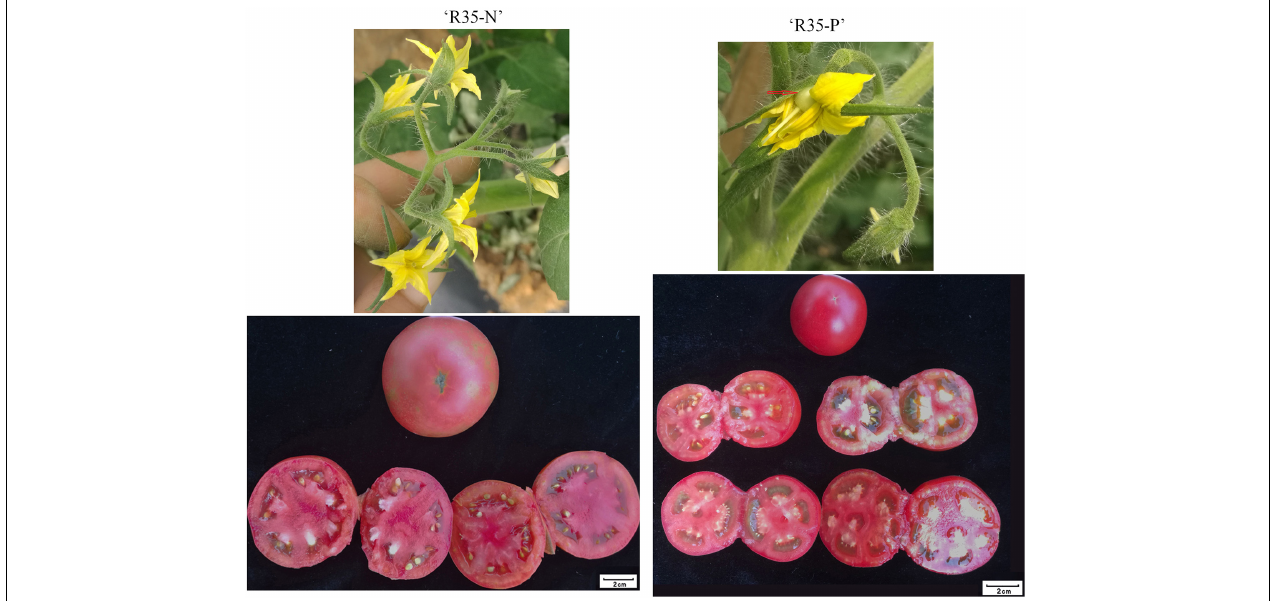
FIGURE 2 | The phenotypes of flowers and tomato fruits of “R35-N” and “R35-P.” The seeded fruits of “R35-N” and “R35-P” obtained by natural pollination at an open field, while the seedless fruits of “R35-P” that obtained flowers emasculation carried 2 days before anthesis.